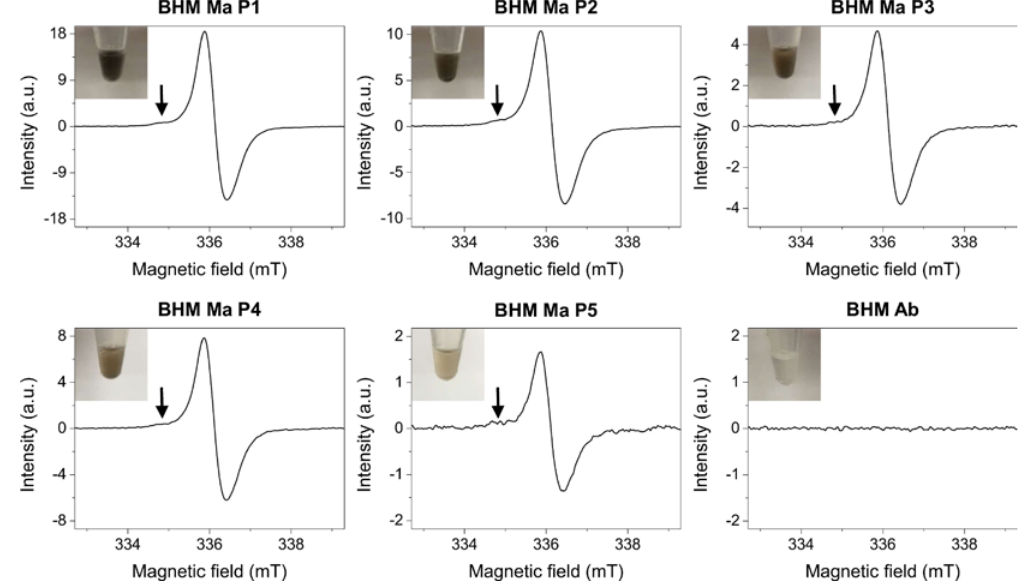
Figure 1. Electron paramagnetic resonance (EPR) spectra of cells examined in this work. Arrows indicate the lower field component attributed to the pheomelanin pigment. Signal intensities are extended to maximum to better show the contribution of pheomelanin component to the EPR melanin spectra. Although the pheomelanin signal seems almost negligible it is worth noting that the detection sensitivity of EPR for pheomelanin determination is nearly an order of magnitude lower than that of eumelanin making the overall contribution of this pigment substantial. Insets show images of cell pallets taken before the analysis.